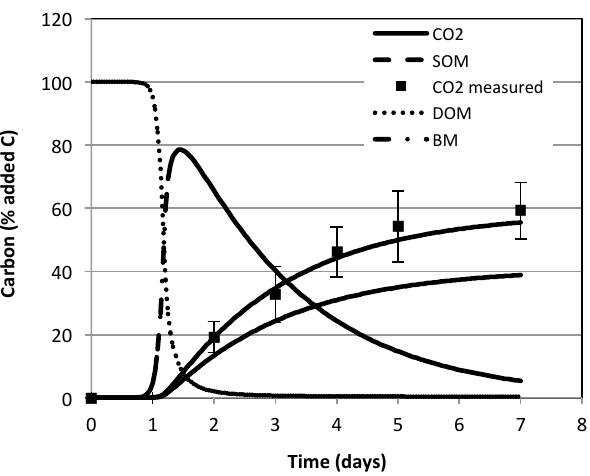
Fig. 7. Calibration of the model parameters from the CO 2 measure- ments during the incubation at high water content, example of bac- teria Figure 7: Calibration of the model parameters from the CO 2 measurements during the incubation at high water content, example of bacteria 7R.